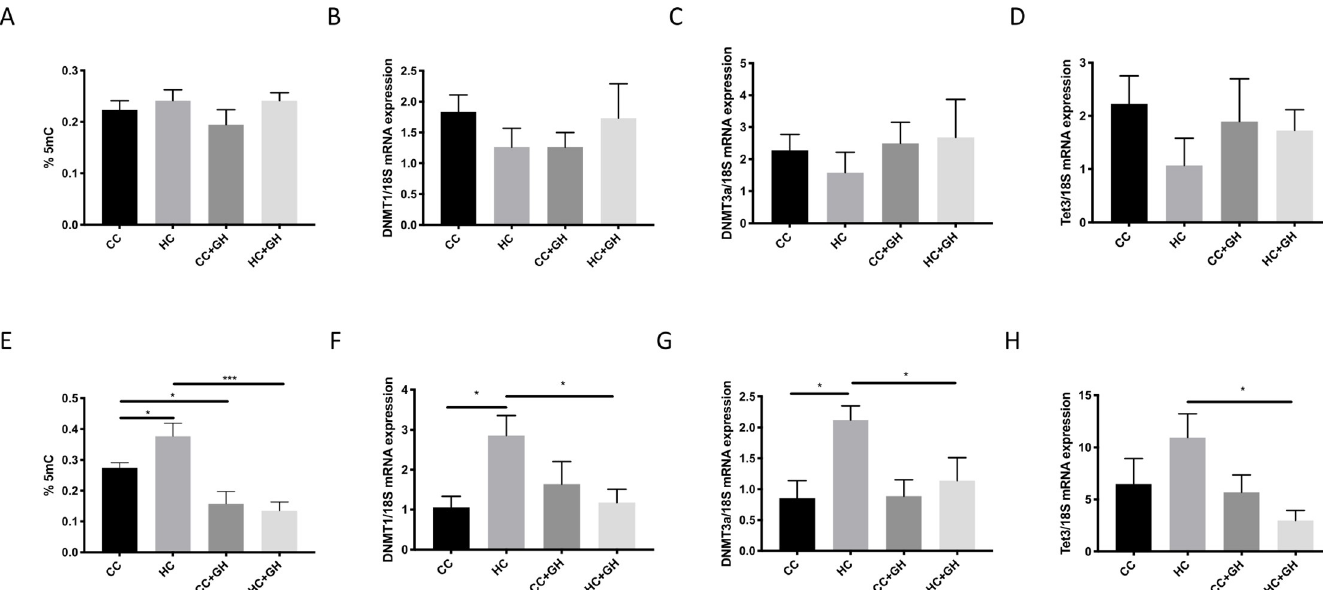
Fig 2. DNA methylation markers. (A) Renal global DNA methylation expressed as % 5mC of total DNA in week 9 offspring, (B-D) week 9 offspring mRNA expression of DNMT1, DNMT3a and Tet3, (E) renal global DNA methylation expressed as % 5mC of total DNA in week 32 offspring, (F-H) week 32 offspring mRNA expression of DNMT1, DNMT3a and Tet3. Results expressed as mean ± SEM, n = 4–6. � p < 0.05, ��� p < 0.001.